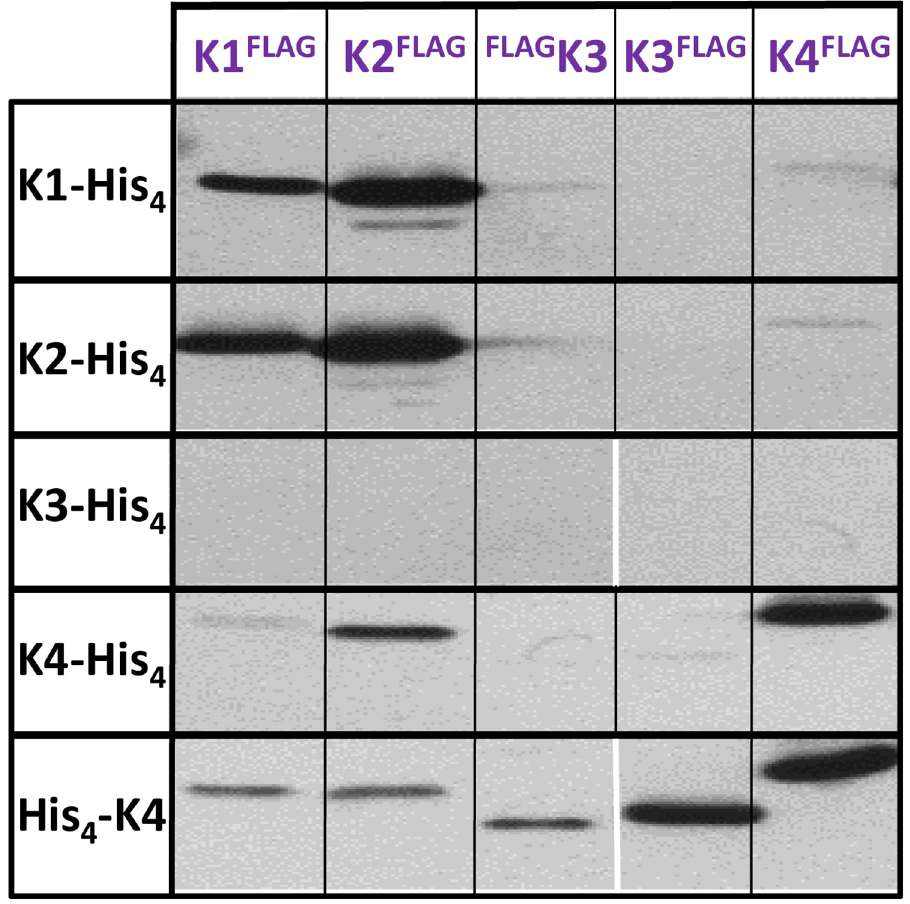
Fig 1. Hetero-hexamer formation with combined Syn6803 CcmK paralogs. Western blot analysis of TALON- purified fractions. After running SDS-PAGE gels, and transferring proteins onto PVDC membranes, detection was performed with a mouse antiFLAG primary antibody followed by a secondary IgG antimouse-alkaline phosphatase fusion. The figure was prepared from two independent western blots that were performed in parallel. White vertical lines are to highlight the resulting image